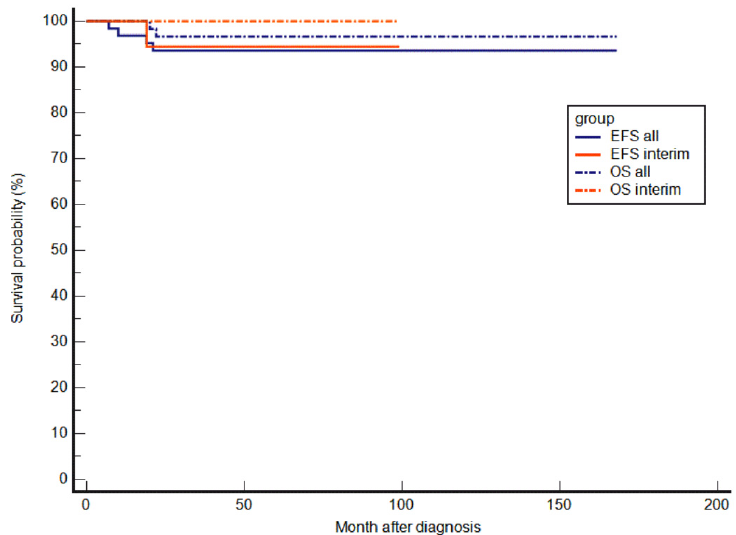
Figure 2. Event-free and overall survival for all patients of the NPC-2003 study and the interim phase ( n = 66) after a median follow-up of 73 months, and for the interim patients alone ( n = 21) after a